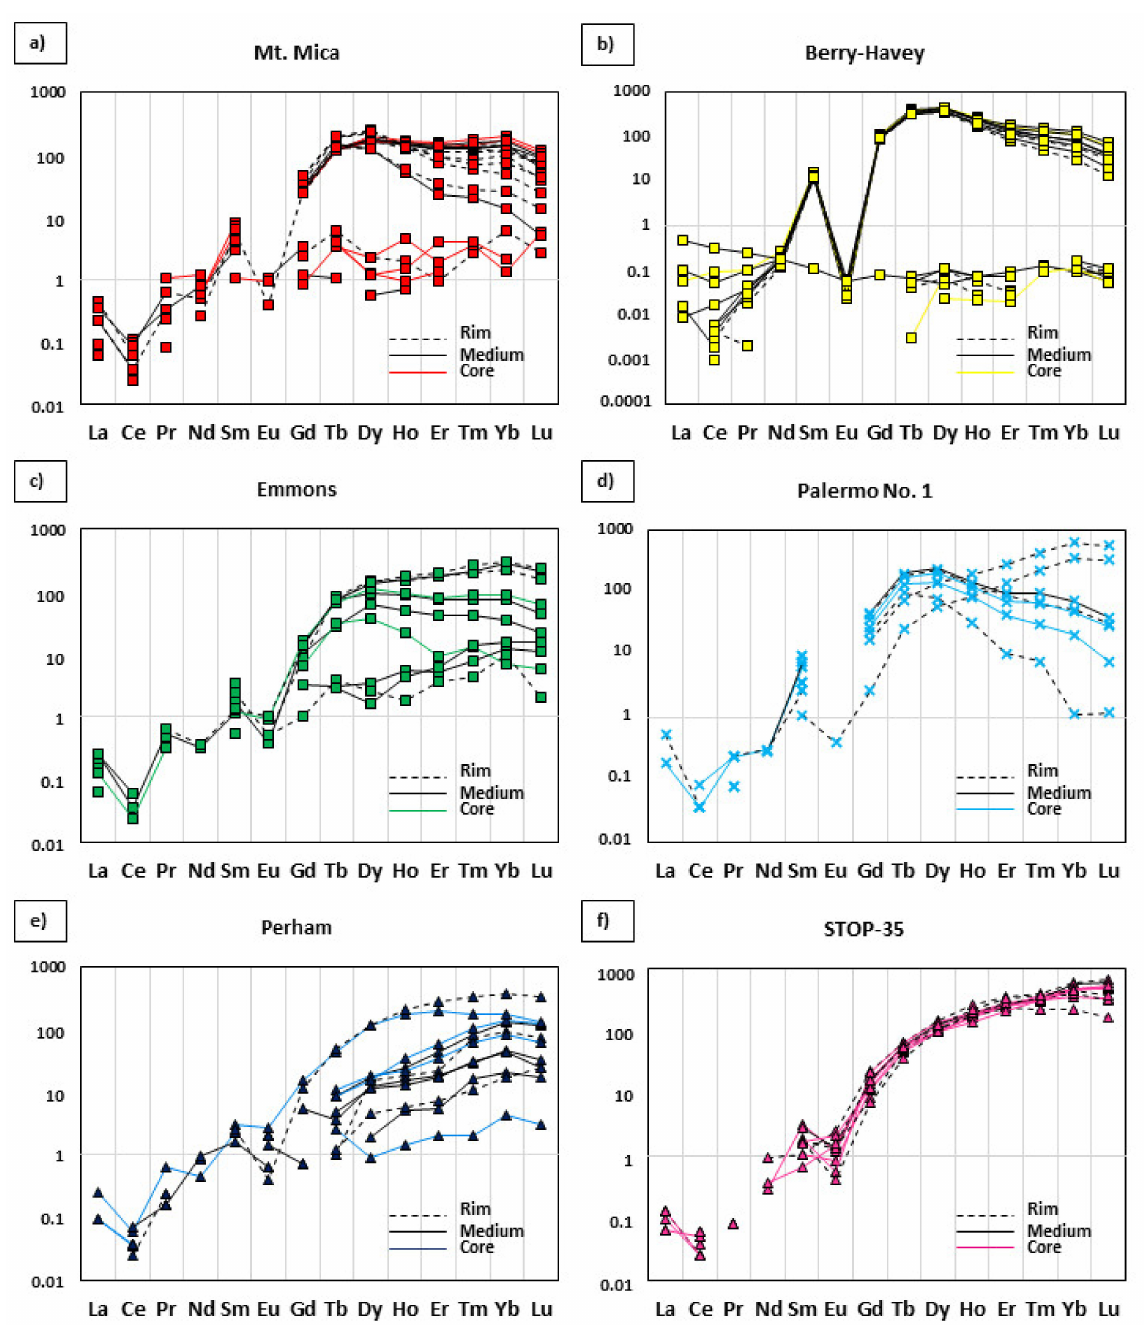
Figure 14. Chondrite normalized [41] REE spider diagrams for garnets from the different pegmatites: ( a – c ) evolved pegmatites; ( d ) intermediate pegmatite; and ( e , f ) barren pegmatites. Differences in the connecting lines indicate the zone of the crystal where the analyses were done (core, intermediate, or